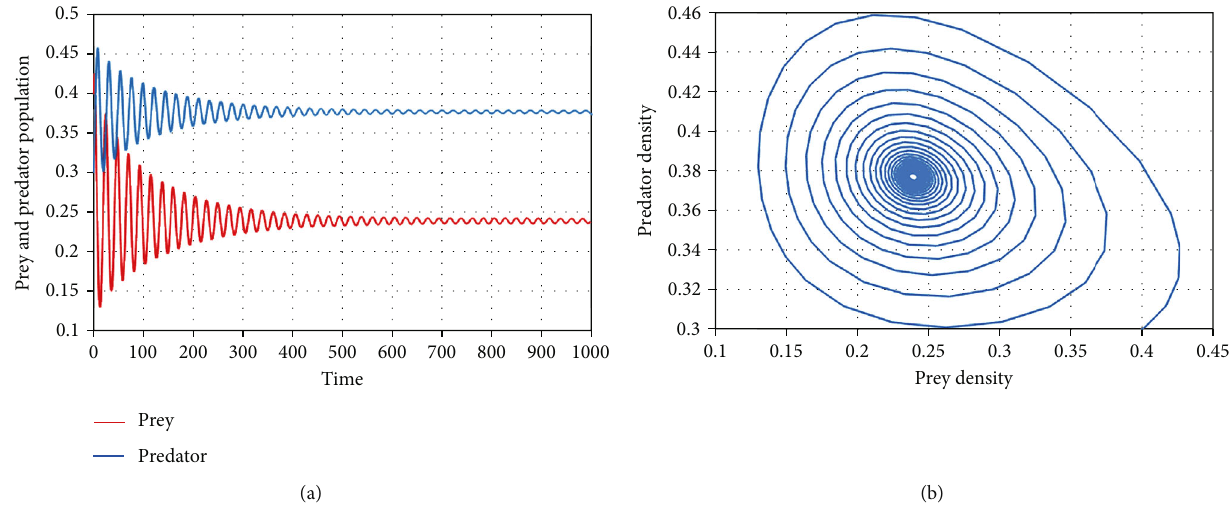
Figure 14: (a) Time series solution and (b) parametric plot of system (4) about the equilibrium point E except c 2 = 0 : 05, c 1 = 0 : 12, α = 1 : 9, and β = 0 : 75 .